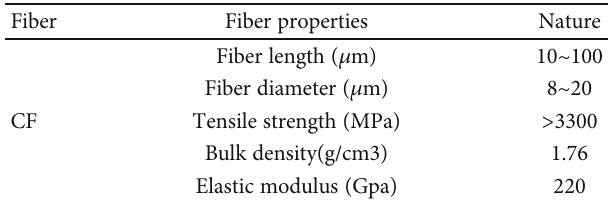
Table 3: Performance parameters of CFs.